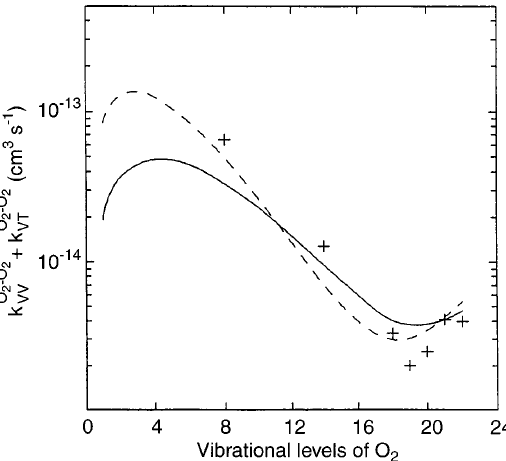
Fig. 6. The dependence of rate coe(cid:129)cients for the VV 0 -processes O 2 (cid:133) n (cid:134) (cid:135) N 2 (cid:133) 0 (cid:134) ! O 2 (cid:133) n (cid:255) 2 (cid:134) (cid:135) N 2 (cid:133) 1 (cid:134) on vibrational level n : dashed line , our calculation; solid line , semiclassical trajectory calculation of Billing (1994); crosses , experimental data of Park and